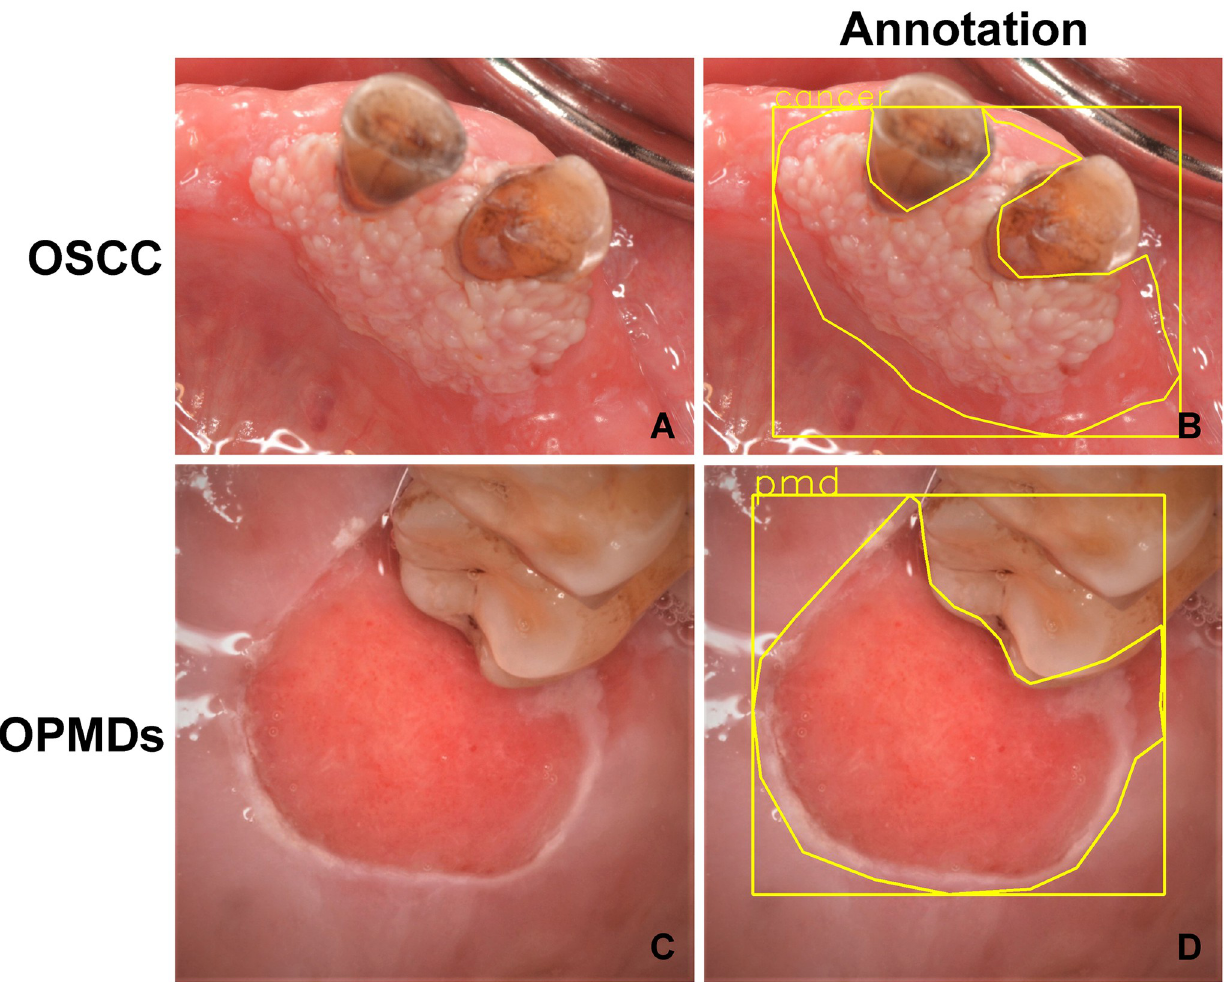
Fig 1. Examples of the OSCC and OPMDs images from the dataset showing. (A) OSCC image; (B) annotation of OSCC image by surgeons; (C) OPMDs image; (D) annotation of OPMDs image by surgeons.